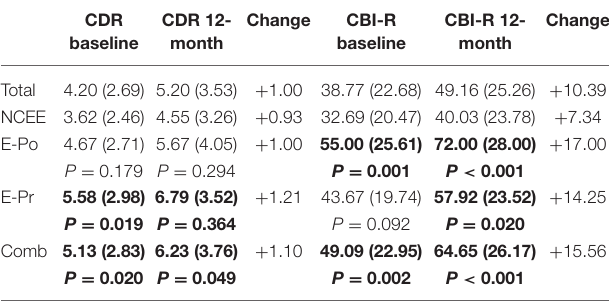
TABLE 5 | Changes in CDR and CBI-R scores (mean and S.D) in AD participants between baseline interview and 12-month follow-up, bold figures indicate significant difference ( p < 0.05) when compared to NCEE